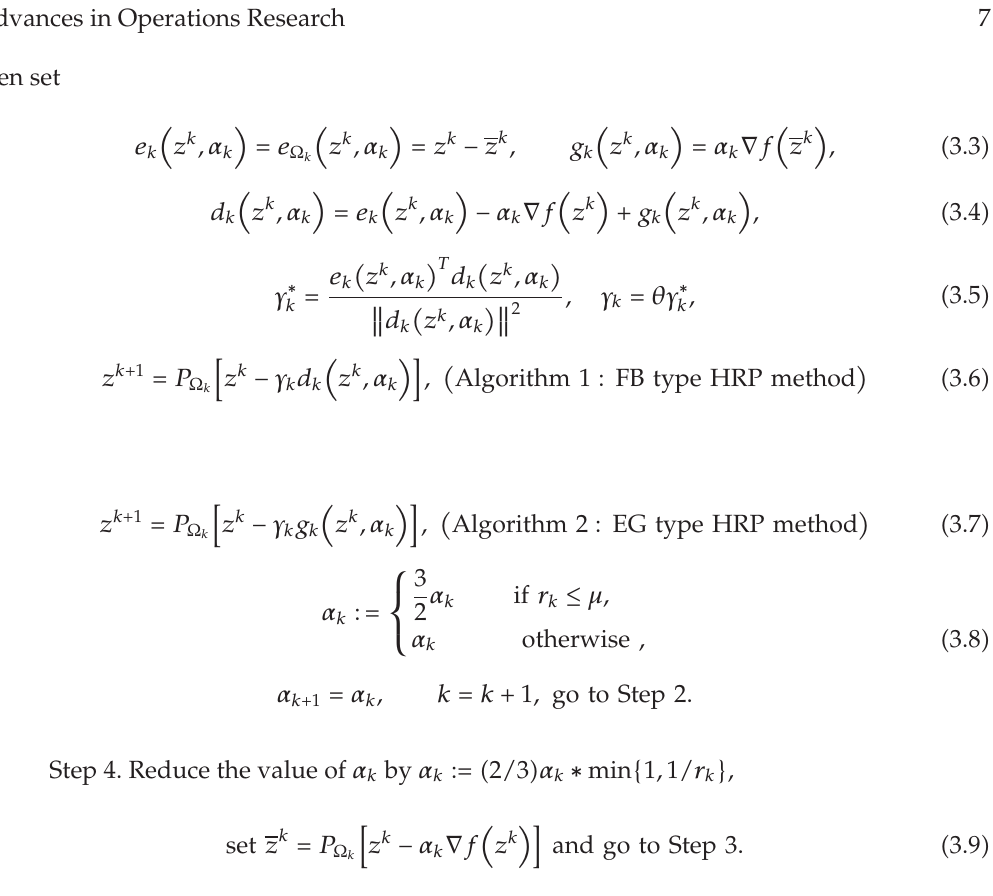
Algorithm 2 : EG type HRP